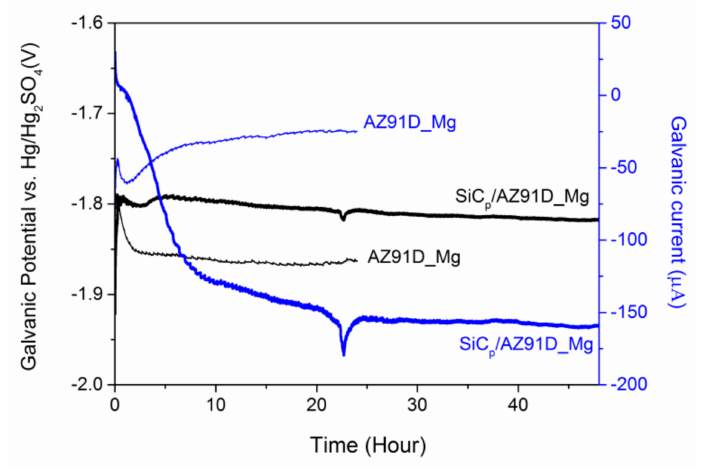
Figure 10. Time behavior of galvanic potential and galvanic current for the AZ91D coating and the SiC/AZ91D composite coating coupled to the magnesium